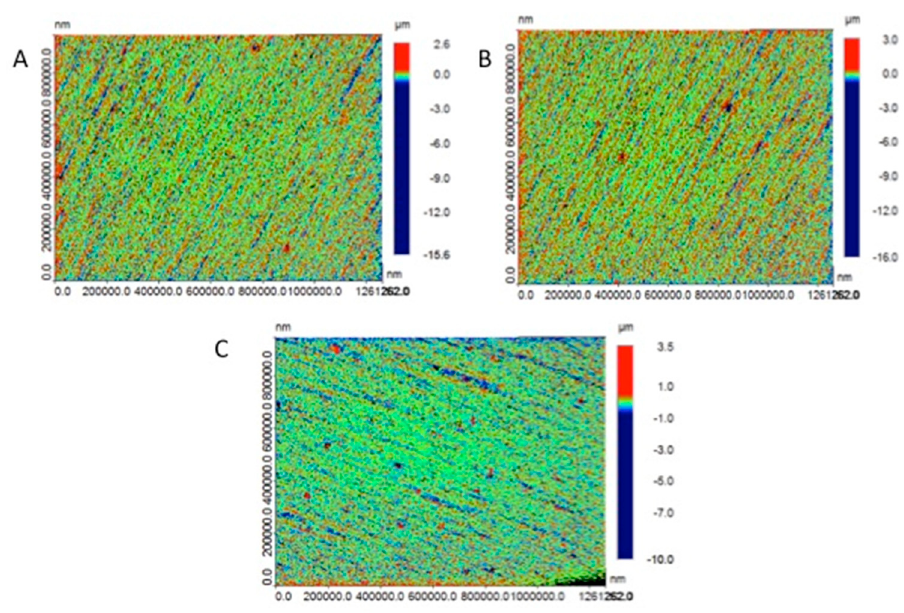
Figure 4. Surface roughness micrographs for study samples in ( A ) conventional ( B ) CAD-CAM, and ( C ) 3D printing groups.